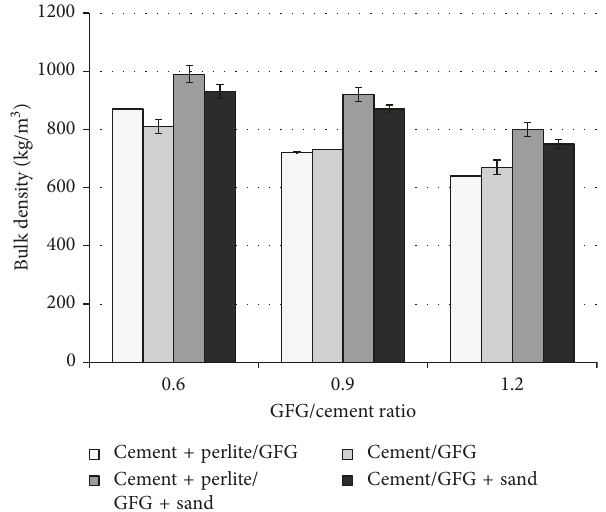
Figure 8: Bulk density of